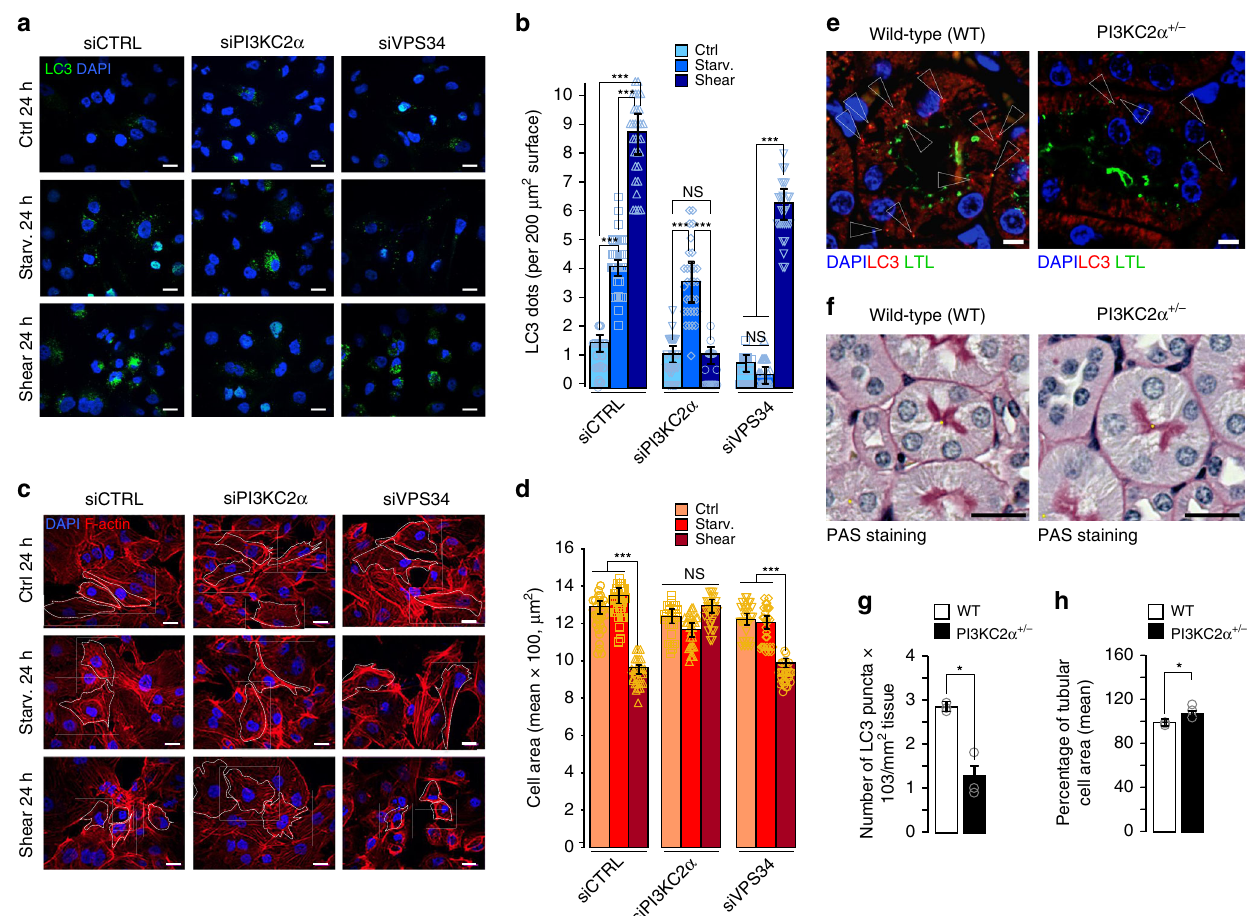
Fig. 3 Shear-stress-induced autophagy and cell size regulation depend on PI3KC2 α , but not on PI3KC3/VPS34. a , c Representative confocal images of polarized HK2 cells (siCTRL), compared to PI3KC2 α knocked down cells (siPI3KC2 α ) and PI3KC3/VPS34 knocked down cells (siVPS34), upon static (ctrl, 24 h), shear stress (24 h) and starvation conditions (24 h, see Methods section for more details), immunostained for LC3, F-actin and DAPI. Scale bar, 10 μ m. b , d Quanti fi cations of ( a ) and ( c ). Bar graphs denote average number of LC3 puncta and average cell areas (mean ± SEM, N = 100 cells,